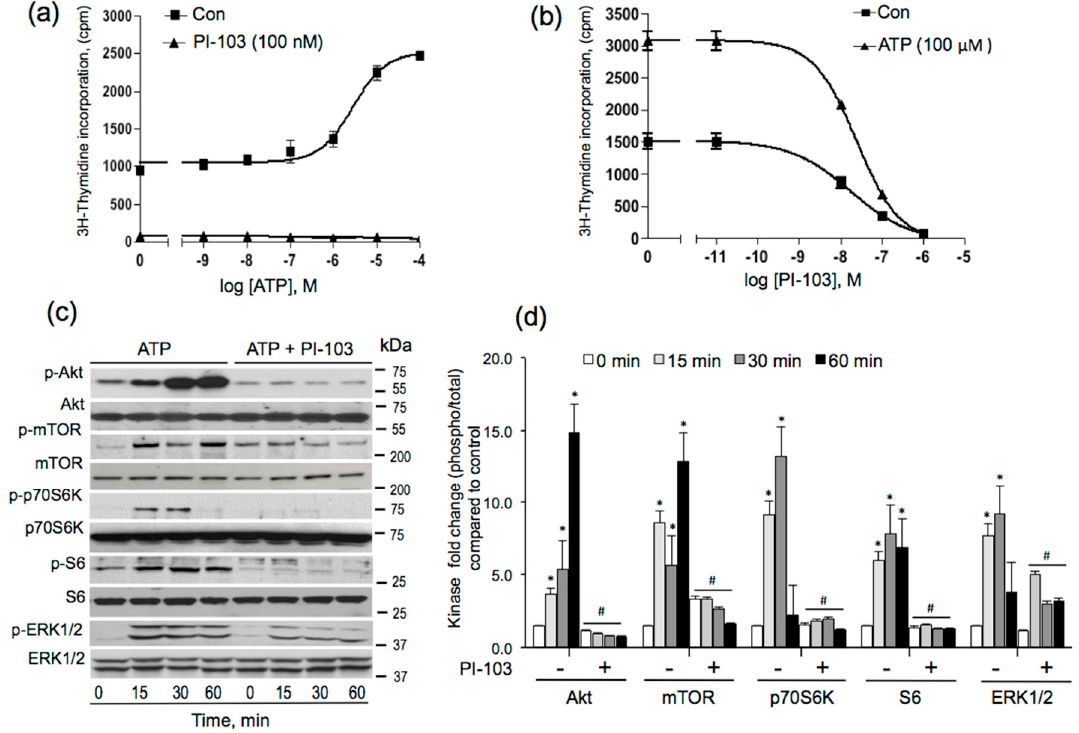
Figure 1. PI-103 inhibits ATP-stimulated DNA synthesis and mitogenic pathways in VVECs. Growth-arrested VVECs remained untreated or were pre-incubated with PI-103 (100 nM, 60 min) and stimulated with ATP (100 µ M) in the presence of 0.125 µ Ci of [ 3 H] thymidine for 24 h. Incorporated radioactivity was measured as described in the Materials and Methods Section (a) E ff ect of PI-103 (100 nM) on ATP-dependent increase in [ 3 H] thymidine incorporation. (b) Concentration-dependent e ff ect of PI-103 on ATP-stimulated [ 3 H] thymidine incorporation; data on panels a and b represent the mean ± SEM from three to six independent experiments (n = 3–6), conducted on three distinct VVEC populations; panel a: p < 0.05 con vs. PI-103-treated; panel b: p < 0.05 con vs. ATP-treated (10 − 11 –10 − 8 M) (one-way analysis of variance); panel b shows non-linear regression analysis of the dose response curves for PI-103; R 2 = 0.99; IC 50 = = 23 nM. (c) Western blot analysis of ATP-stimulated phosphorylation of intracellular kinases and S6 protein in the absence and the presence of PI-103 (100 nM). (d) Graphical presentation of the Western blot data; data on panel d represent the mean ± SEM from three independent experiments (n = 3), conducted on three distinct VVEC populations; ATP-stimulated phospho-protein levels at 15, 30, and 60 min were compared to time 0. The e ff ect of PI-103 was determined individually at each time point in the control and ATP-treated cells; * p < 0.05 con vs. ATP-stimulated, # p < 0.05 PI-103-untreated vs. PI-103-treated for each kinase (unpaired, two-tailed t test).